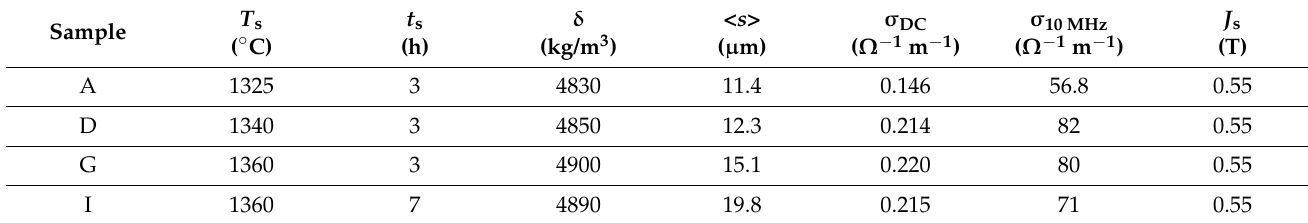
Table 1. Physical parameters of the selected Mn-Zn ferrite ring samples. T s ≡ sintering temper- ature; t s ≡ sintering time; δ ≡ mass density; < s > ≡ average grain size; σ DC ≡ DC conductivity; ≡ conductivity at 10 MHz; J s ≡ saturation σ 10MHz